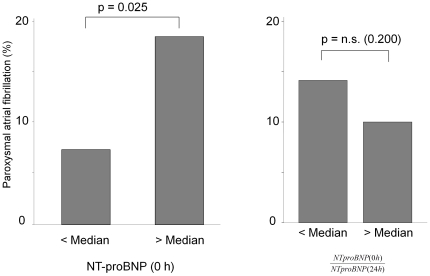
NT-proBNP and NT-proBNP ratio and paroxysmal atrial fibrillation.Left panel: Percentage of study participants with paroxysmal atrial fibrillation on Holter monitoring in the two sub-groups of patients with NT-proBNP plasma levels below and above the median NT-proBNP plasma level (239 pg/ml). Right panel: Percentage of study participants with paroxysmal atrial fibrillation below and above the median ratio of early (0 h) to late (24 h) NT-proBNP plasma level (0.78).